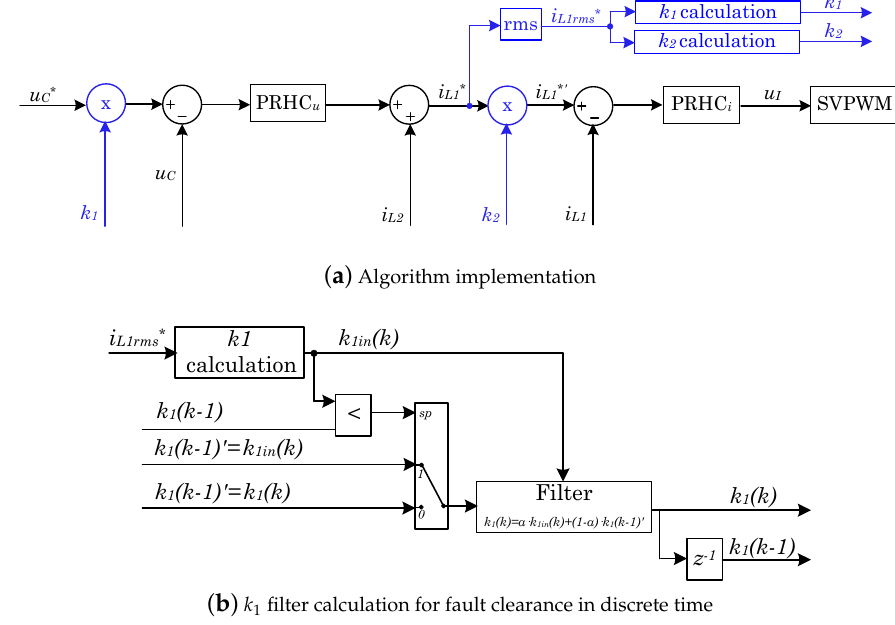
Figure 7. Control schemes of the sinusoidal wave short-circuit proof